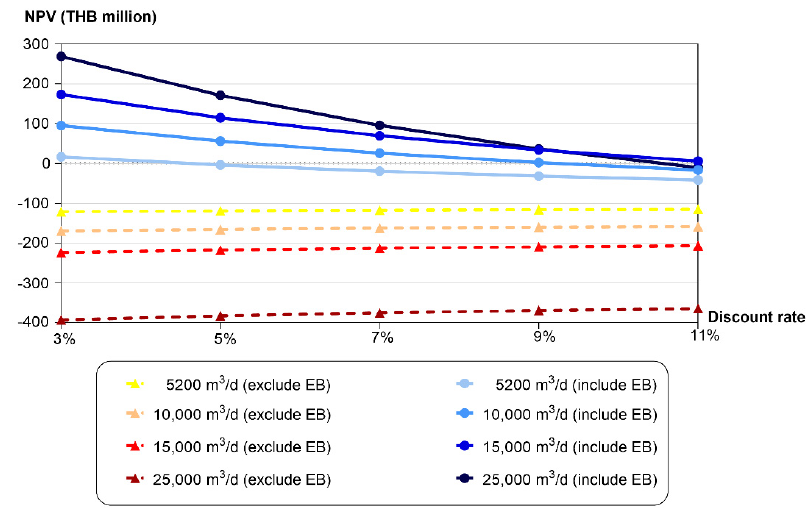
Figure 3. Net present values (NPVs) for water reclamation projects for industrial water supply, with the inclusion or exclusion of environmental benefits (EB). Table 3. Internal rates of return for water reclamation projects for industrial water supply when including environmental benefits.